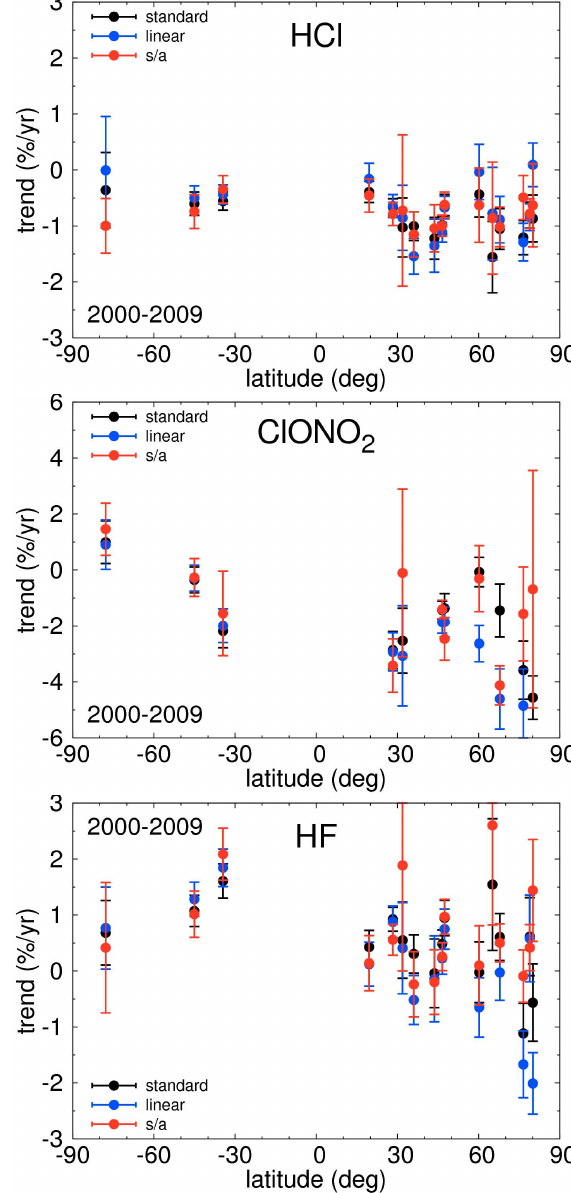
Fig. 9. Dependence of the resulting trend (in % per year) on the type of fitting function, determined from the FTIR measurements of HCl (top), ClONO 2 (mid), and HF (bottom) for the time range 2000– 2009 (except at Toronto where it is 2002–2009, and at Poker Flat it is 2000–2004). Please note the different y-scales. The results of the “standard” procedure using a linear function with a third or first or- der Fourier series are shown in black, those of the “linear” trend cal- culation in blue and of the linear calculation with summer/autumn data only (“s/a”) in red. The error bars were determined with the bootstrap method. Concerning the reasons for missing trend values please see